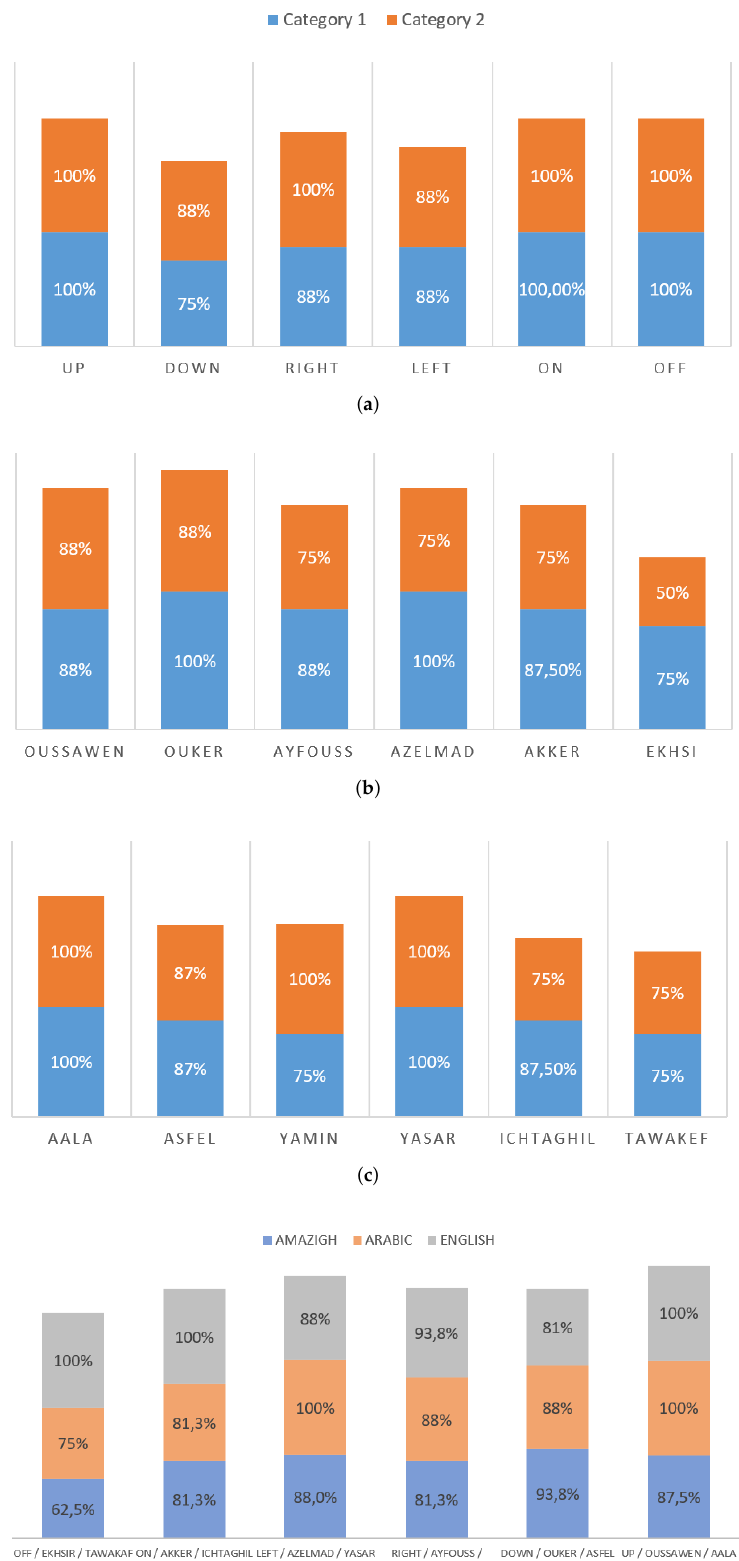
Figure 13. Accuracy results on test data for different spoken words: ( a ) English, ( b ) Amazigh, ( c ) Arabic, and ( d )